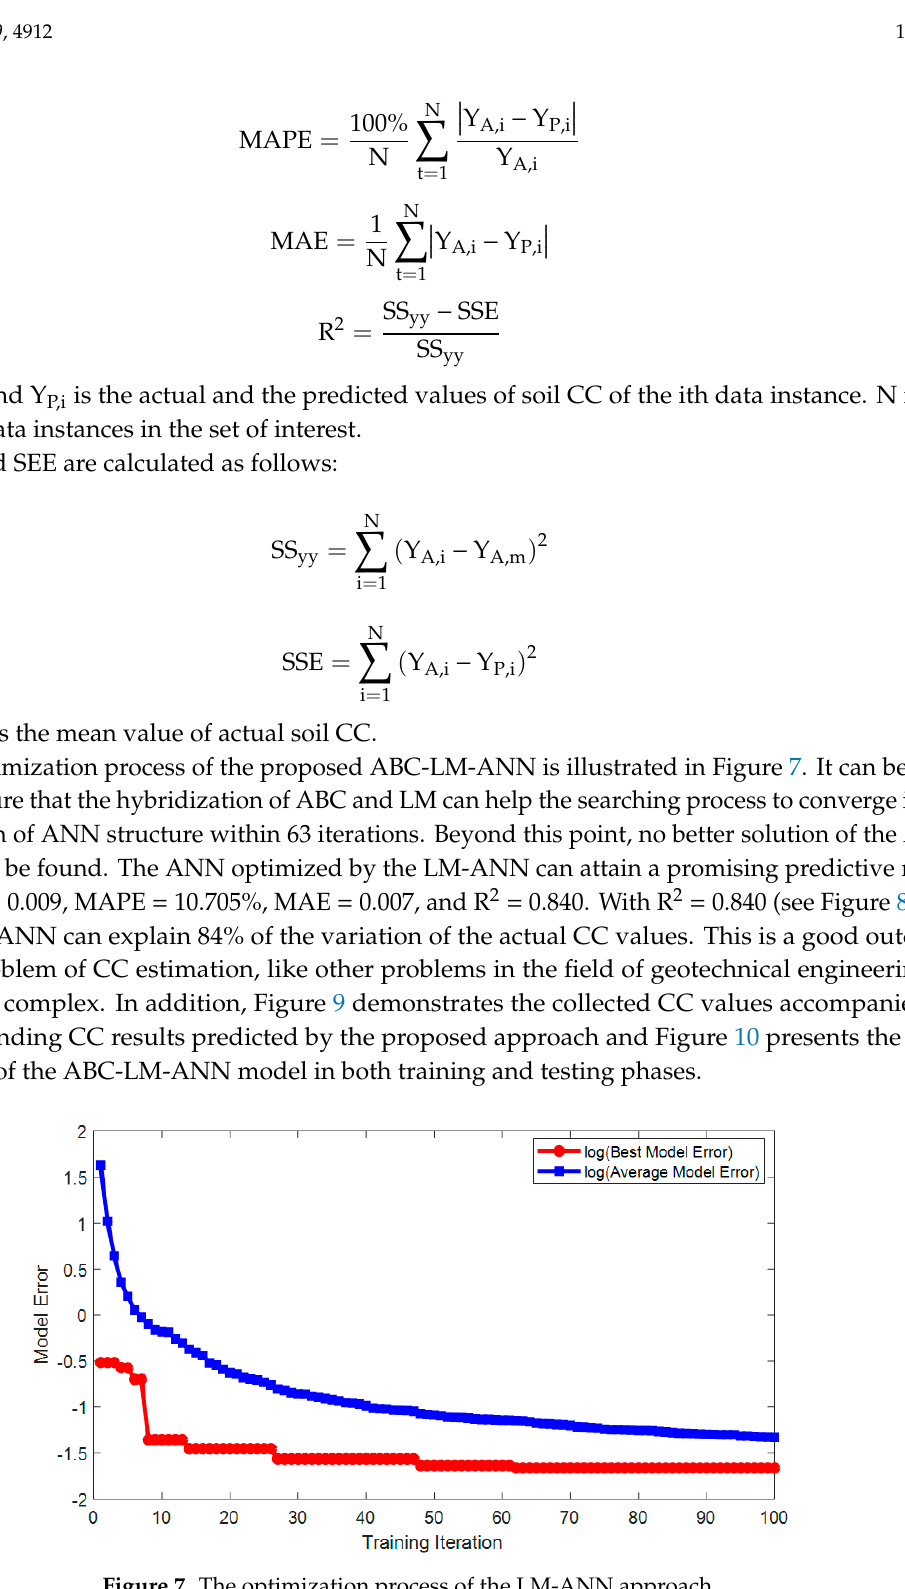
Figure 8. The performance of the proposed ABC-LM-ANN model used for predicting CC. Figure 9. The actual CC vs. the value of CC predicted by the proposed ABC-LM-ANN model.